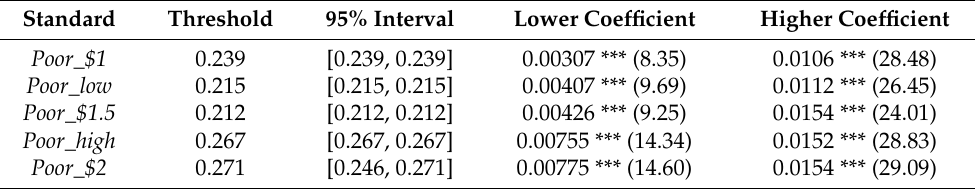
Table 18. Threshold estimates and confidence intervals and coefficient